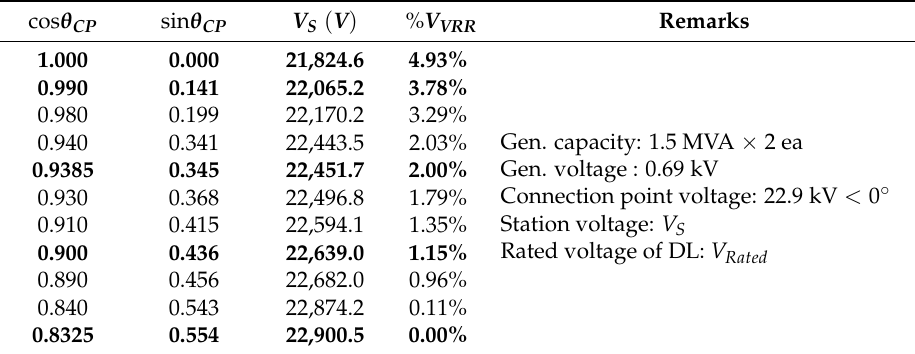
Figure 5. Single line diagram of application site. Table 2. Voltage rise rate according to power factor. % V VRR : voltage rise rate (%).